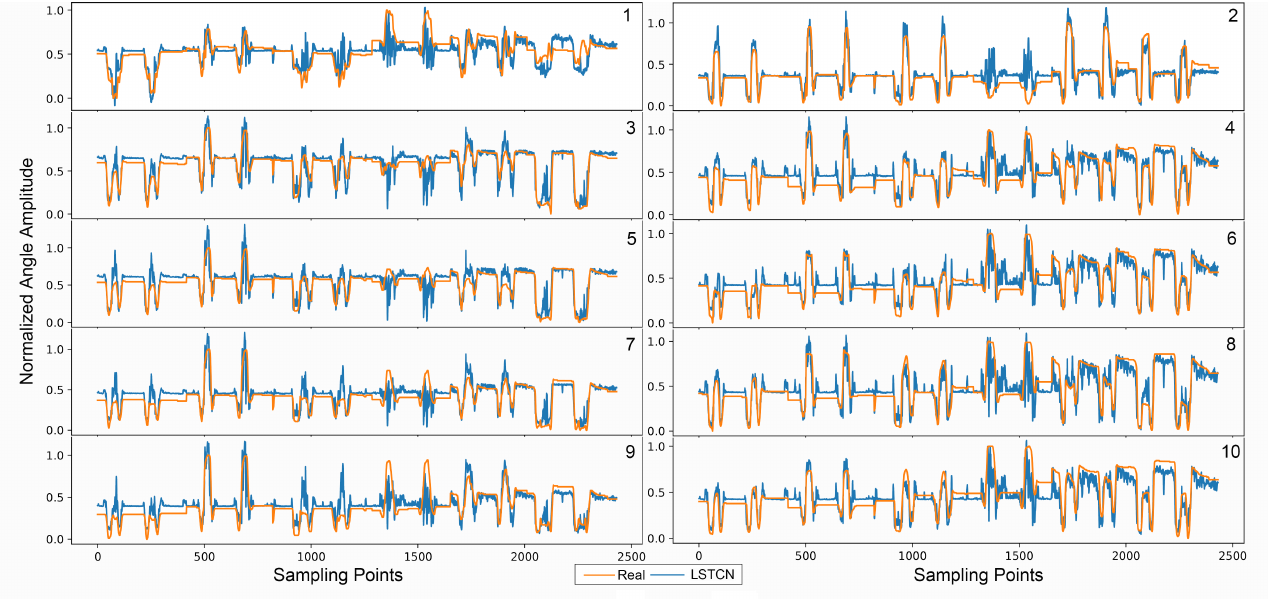
Figure 11. The continuous amplitudes of real and predicted joint angles using LS-TCN. There are 10 subfigures for 5 fingers (i.e., two joints per finger as depicted in Figure 2), and each subfigure denotes the result of a finger joint, where the x-axis represents the sampling point index and the y-axis denotes normalized joint angle. Each movement was performed twice, and thus two peaks or two valleys represents one repeated movement; i.e., 6 grasping movements are characterized by 12 peaks/valleys in each